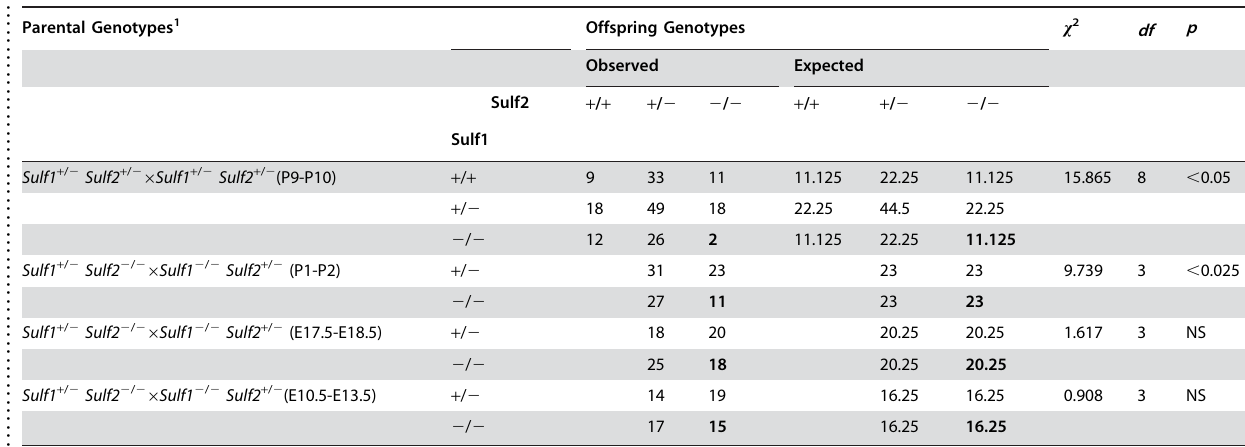
Table 2. Sulf1 2 / 2 Sulf2 2 / 2 mice exhibit neonatal lethality. .. ... .... ... ... .... ... ... .... ... ... .... ... ... .... ... ... .... ... ... .... ... ... .... ... ... .... ... ... .... ... ... .... ... ... .... ... ... .... ... ... .... ... ... . Parental Genotypes